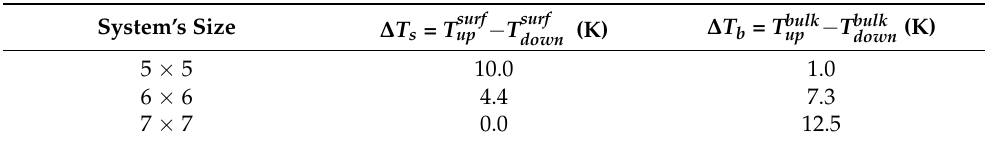
Table 3. Evolution of the width of the thermal hysteresis ∆ T = T up − T down as a function of the size of the 2D system corresponding to Figure 3. The computational parameters are: ∆ / k B = 1300 K, L / k B = 290 K, G / k B = 172 K, J bb / k B = 60 K, J ss / k B = 50 K, J bs / k B = 20 K and ln( g ) = 6.01.